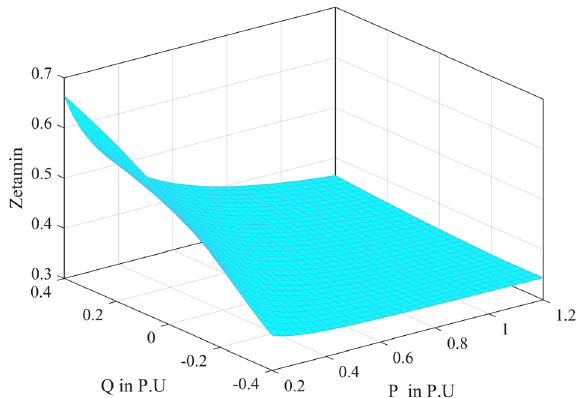
Fig. 10 The minimum damping ratio of the closed loop system for all 1024 operating conditions